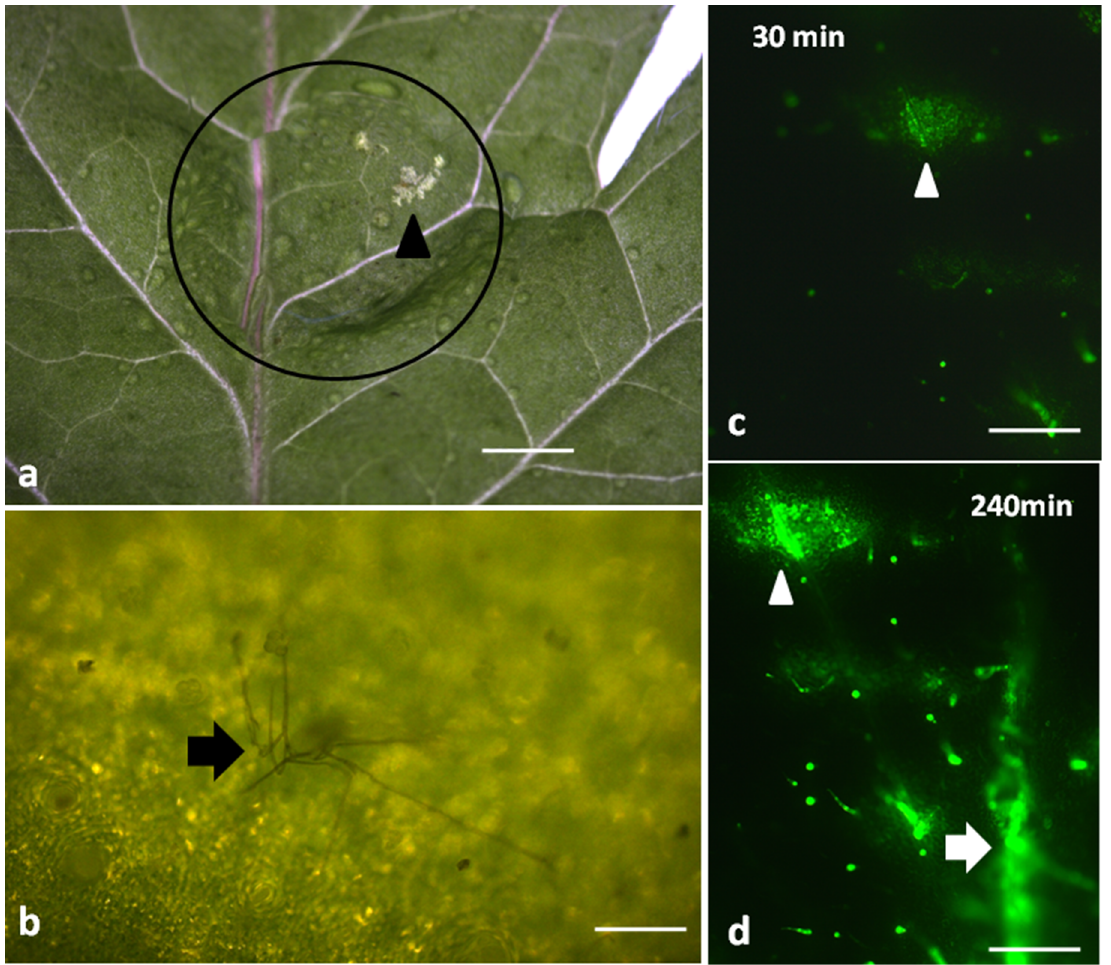
Figure 1. A visible damage (arrowhead) can be observed on a tomato leaf 24 h after application of a Botrytis cinerea spore suspension drop (circle) ( a ). B. cinerea hyphae (arrow) visible on the leaf epidermis 24 h after the spore suspension application ( b ). Staining of tomato leaflets with 2 ′ , 7 ′ -dichlorofluorescein diacetate (DCF-DA) for hydrogen peroxide (H 2 O 2 ) detection after 30 ( c ) and 240 min ( d ) of B. cinerea application. Hydrogen peroxide generation is visible as green fluorescence ( c , d ). Scale Bars: 1 mm in ( a ), 0.2 mm in ( b ), and 500 μ m in ( c , d ).